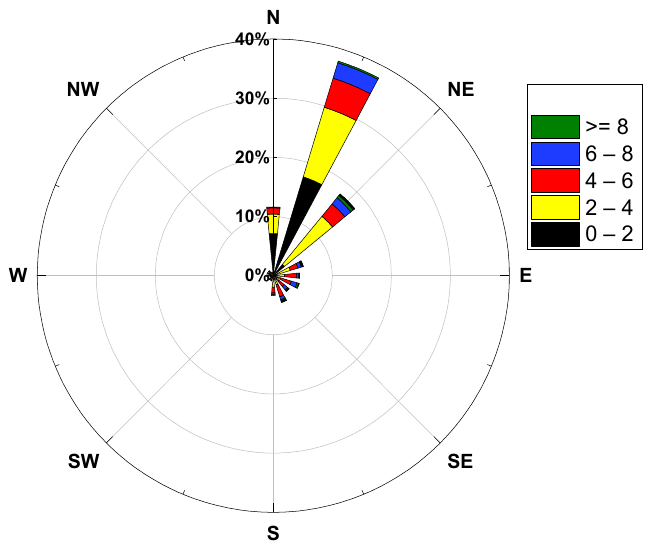
Figure 2. Wind speed and wind direction.